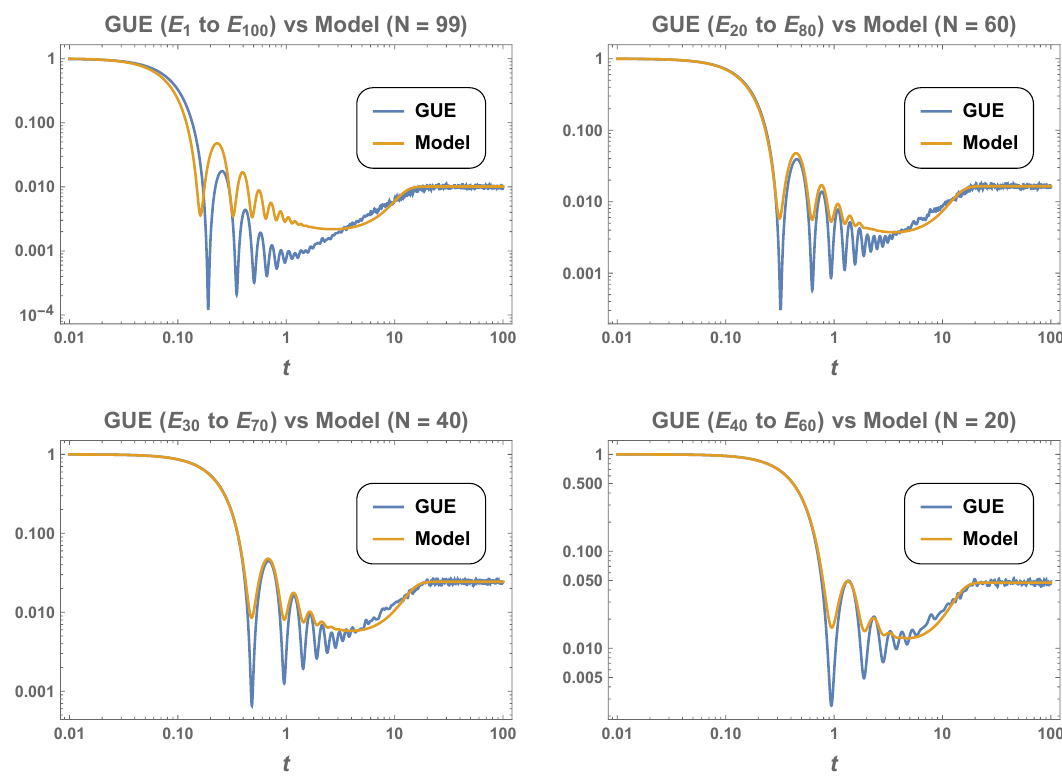
Figure 19 . Plot depicts a comparison of the infinite temperature form factor of the GUE computed numerically using eq. (C.4) and our i.i.d model with NNS distribution given by eq. (C.7). The top left plot depicts the a comparison with all eigenvalues in the GUE spectrum. Top right plot depicts a comparison with GUE form factor for roughly 60% of the eigenvalues within the centre of the spectrum. Bottom left depicts a comparison with GUE form factor for roughly 40% of the eigenvalues within the centre of the spectrum. Bottom right depicts a comparison with GUE form factor for roughly 20% of the eigenvalues within the centre of the spectrum. We see that as the window focuses on the centre eigenvalues the deviations between the form factor for the i.i.d model and GUE become smaller at all time